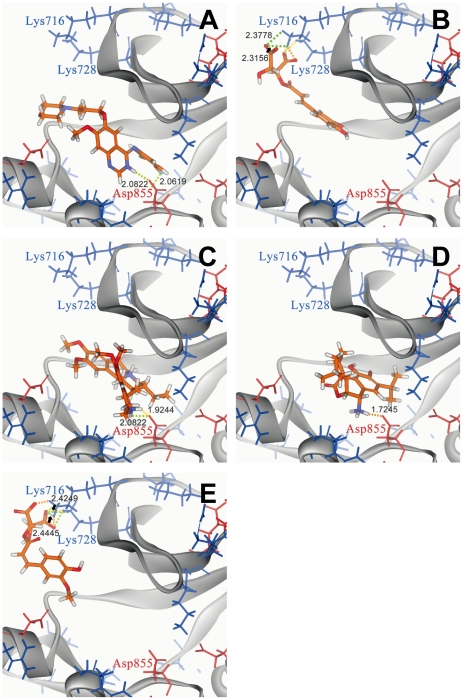
Docking pose of different compounds in EGFR using LigandFit.(A) Iressa, (B) 2-O-Caffeoyl tartaric acid, (C) Emetine, (D) Rosmaricine, and (E) 2-O-Feruloyl tartaric acid. Binding site amino acids are shown in red (negatively charged amino acids) and blue (positively charged amino acids). Hydrogen bonds are color coded based on bond distance: 1.6–1.8Å (orange), 1.8–2.0Å (yellow), 2.0–2.2Å (light green), 2.2–2.4Å (neon green), and 2.4–2.5Å (dark green).